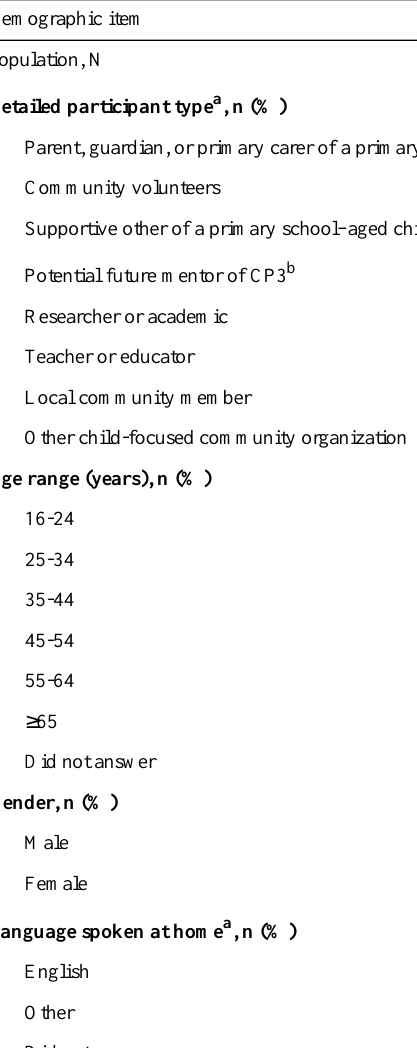
Table 1. Basic participant